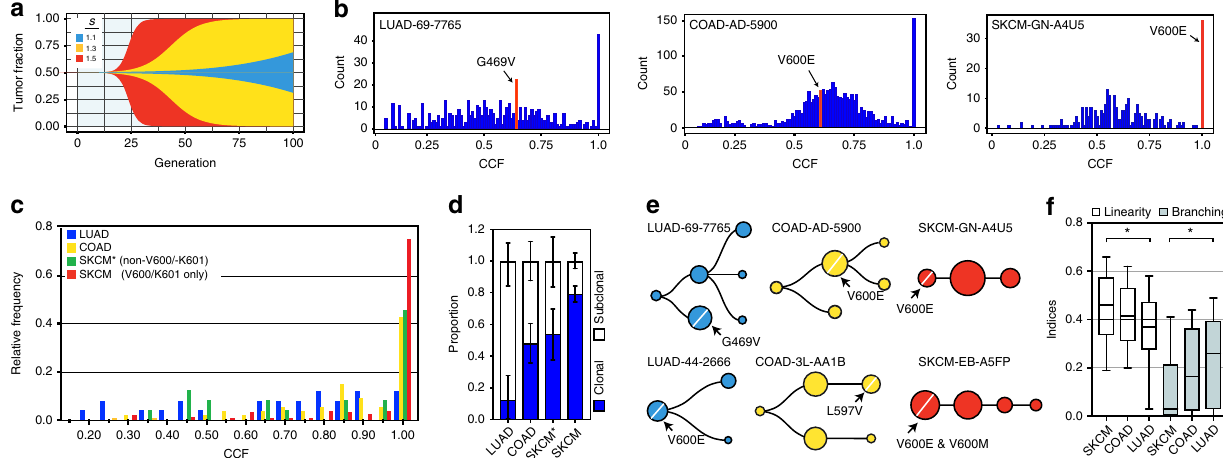
Fig. 2 Measuring BRAF -variant fi tness in sequencing data. a Subclones with low or high fi tness advantages achieve fi xation at distinct rates when under selection. Tumor and subclone ages were 100 and fi ve generations, respectively. b Allelic fractions for mutations in three representative tumors from TCGA were rescaled to estimates of cancer cell fraction (CCF) by correcting for sample purity and local copy-number. The position of the BRAF -variant CCF is designated in red. c The relative frequency of BRAF -variant CCF values across cancer type is shown. SKCM was further strati fi ed by the hyperactivating mutations V600 and K601. d Proportion of tumors with estimated subclonal BRAF -drivers across cancer types. e The clonal evolutionary structure of each tumor is depicted in the form of a rooted tree. The tree with the lowest normalized log likelihood value ( “ best tree ” ) ” ) is shown for representative tumors from each cancer type. Cancer types are organized by color: LUAD (blue), COAD (yellow) and SKCM (red). The root node represents the clonal fraction and branched nodes represent subclones. Node size re fl ects the number of mutations that constitute the (sub)clone. Arrows indicate the position of the BRAF variant(s) in the tree. f Box-plot (median, inter-quartile range, and minimum/maximum) of linearity and branched indices for evaluable tumors across the designated cancer types are shown. Only primary (non-metastatic) tumors were evaluated. The P -value of Welch ’ s t -test comparing SKCM to LUAD was <0.05 and <0.01 for linearity and branching,